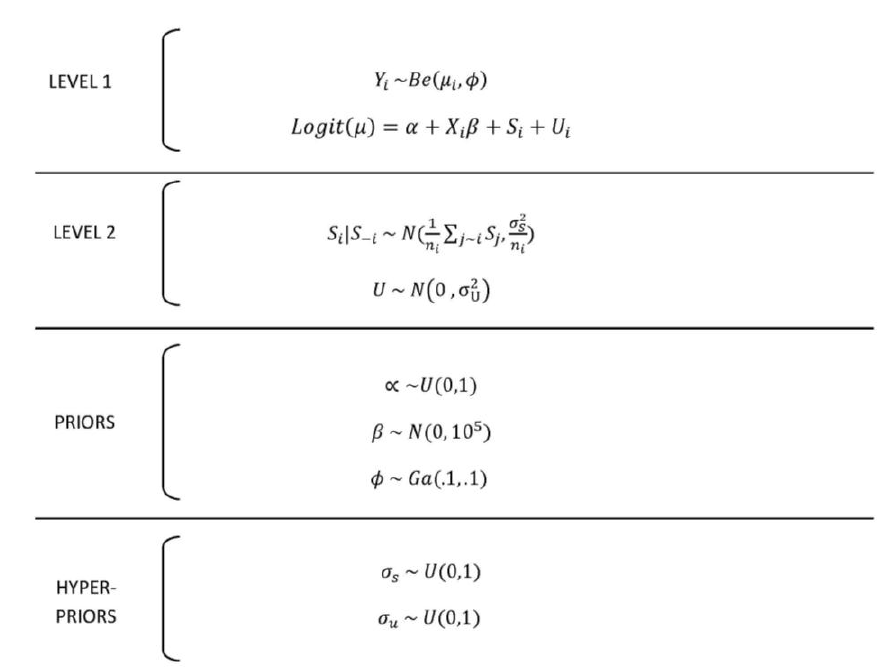
Figure 1. Illustration of the model.